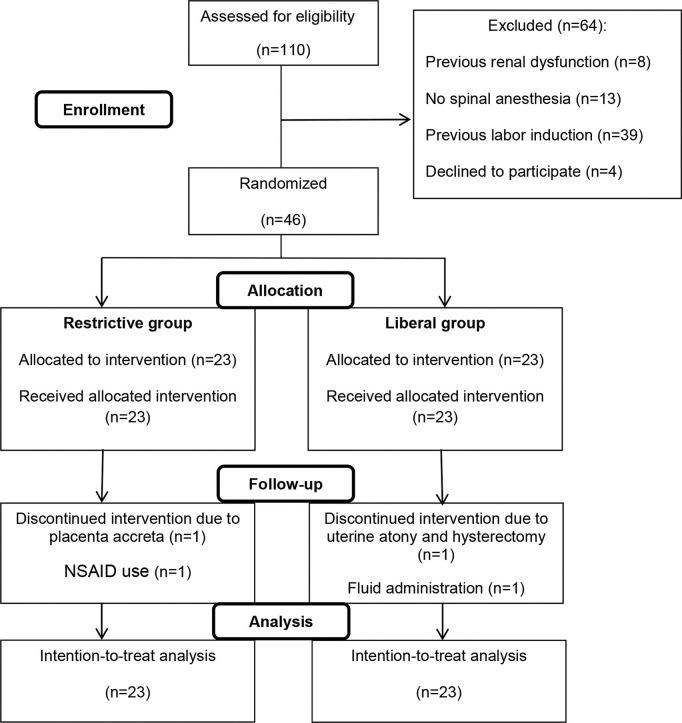
Flow chart of the study design.